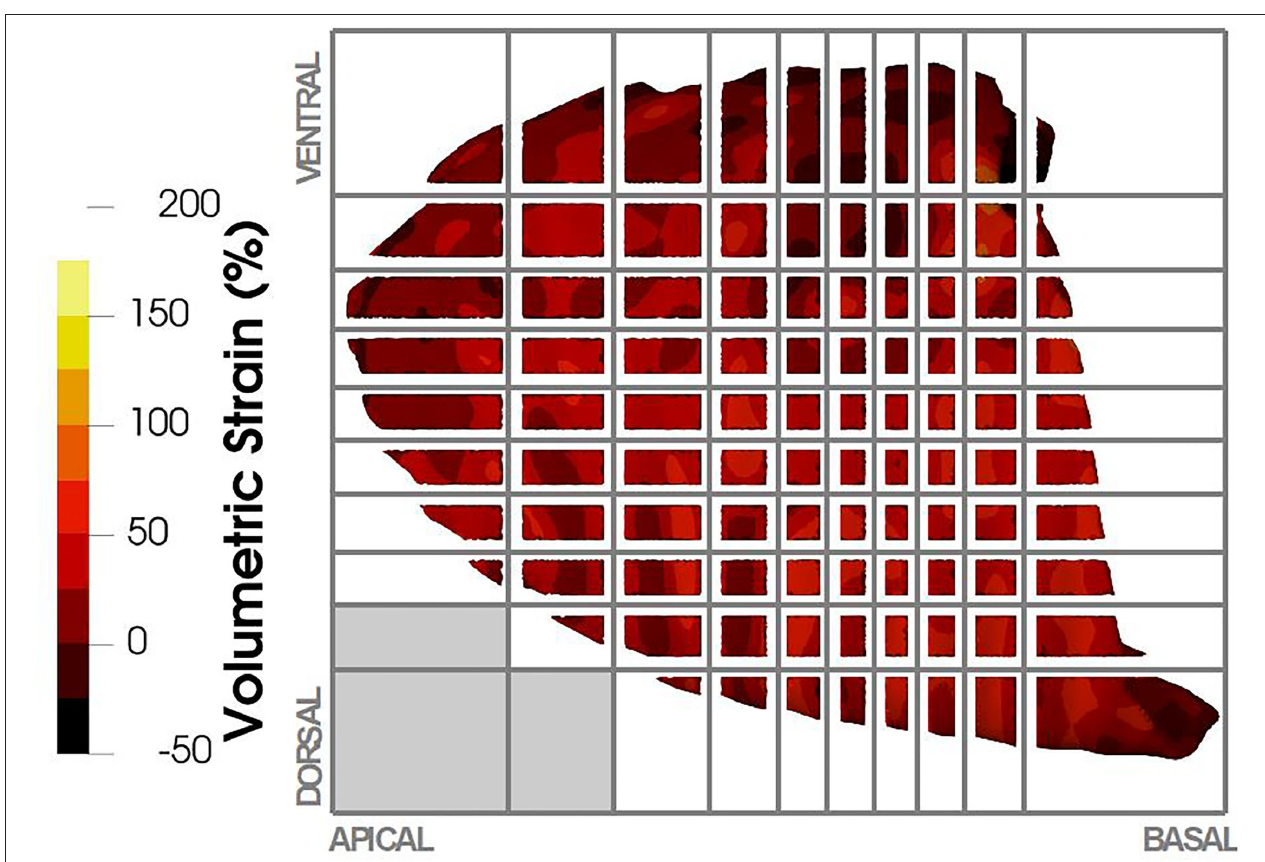
FIGURE 2 | Regional volumetric strain was reported in terms of regions of interest (ROIs). ROIs were defined based on a volumetric partition of the lung as shown in the figure, where 10 planes were defined in the apicobasal direction and 10 planes in the dorsoventral direction. The intersection of these planes defined the ROIs in the lung. Depending on the lung anatomy, some regions did not contain lung tissue (e.g., lower left ROIs in the figure), and therefore no strain was reported for those